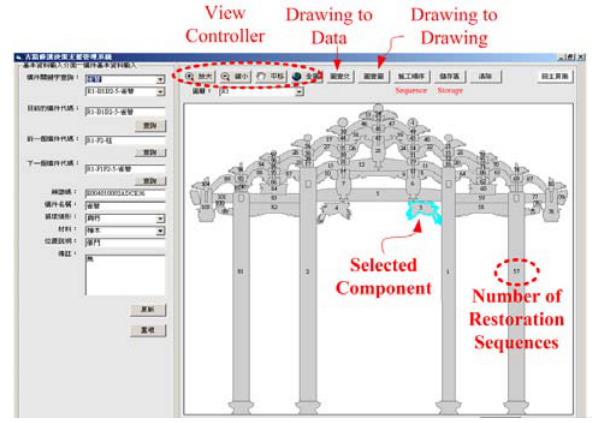
Fig. 13. GIS-based functions of server sub-system